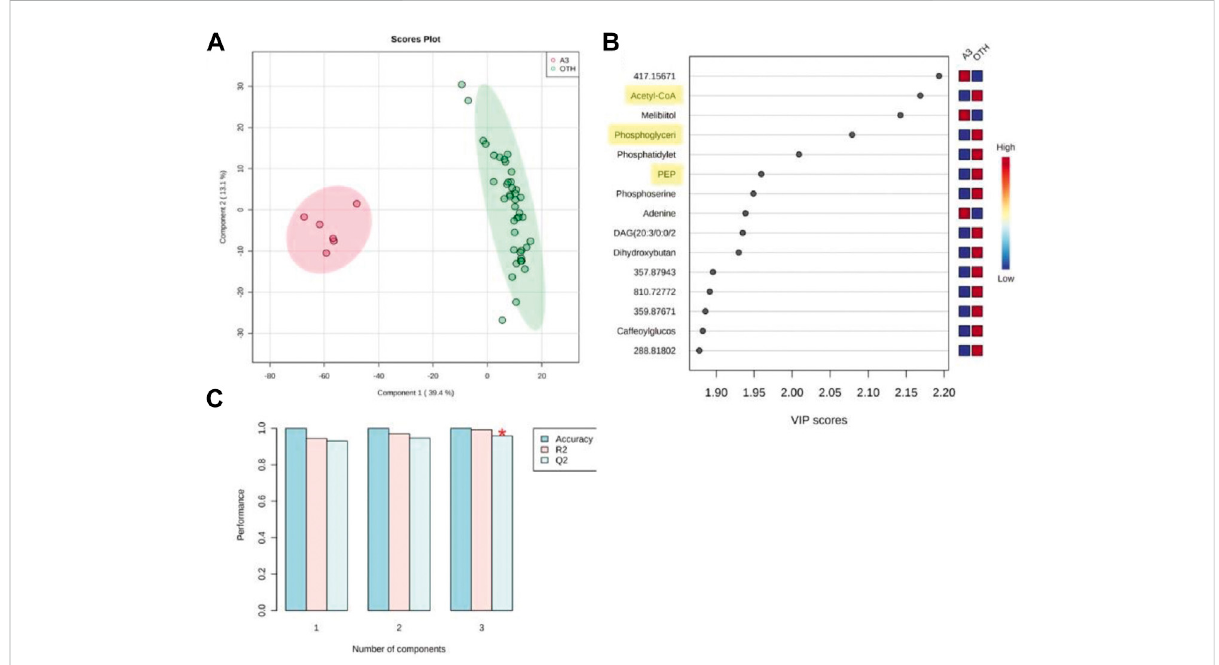
FIGURE 4 Partial least squared discriminant analysis (PLS-DA) of antibiotic-treated MRSA metabolomes. (A) PLS-DA score plots (95% con fi dence interval illustrated show as paler colored ellipses) of normalized m/z intensities of metabolites extracted as detected by fl ow-infusion electrospray high- resolution mass spectrometry (FIE-HRMS) from MRSA treated with A3 (Hb5d/e3) and compared to all other ( “ OTH ” ) treatments of vancomycin, levo fl oxacin, and nalidixic acid and chloramphenicol, gentamycin, and streptomycin for both positive and negative modes for time points. (B) Validation ofthe PLS-DAmodelbased on leave-one-out cross-validation (LOOCV) showing thehighaccuracyof themodel, R2, thegoodness of fi t, and Q2, the goodness of prediction. (C) Variable importance in projection (VIP) scores for the PLS-DA. The relative levels of m/z with A3 or OTH treatments are indicated. Metabolites involved in glycolysis/gluconeogenesis are highlighted in